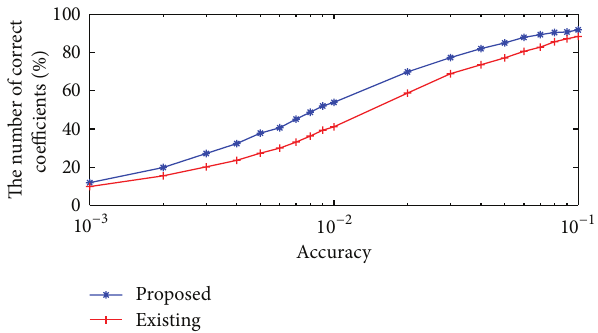
Figure 3: Accuracy comparison between the standard integer DCT and proposed AI-based Arai